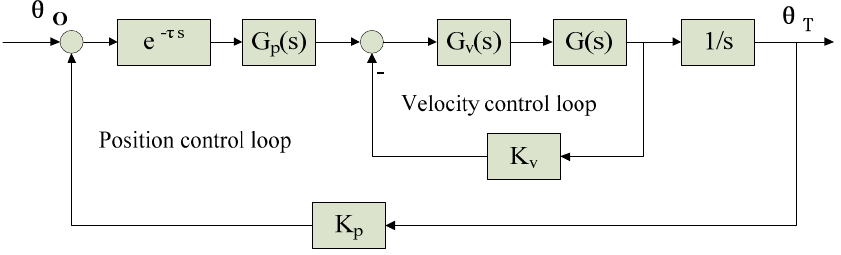
Figure 2. Diagram of position control loop and velocity control loop.